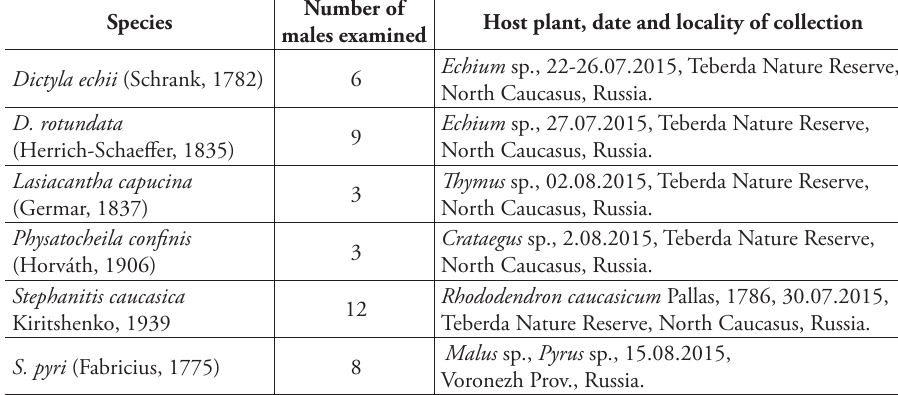
Table 1. Material used for chromosome analysis.